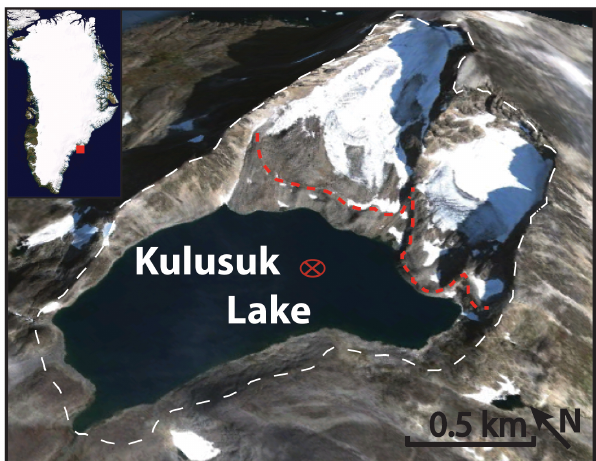
Figure 1. Location and catchment setting of Kulusuk Lake. The white dashed line marks the watershed boundary and the red dashed line defines the crest of moraines in front of both glaciers mapped in the field. Cores were collected in the deepest basin (red circle). Image: Google,